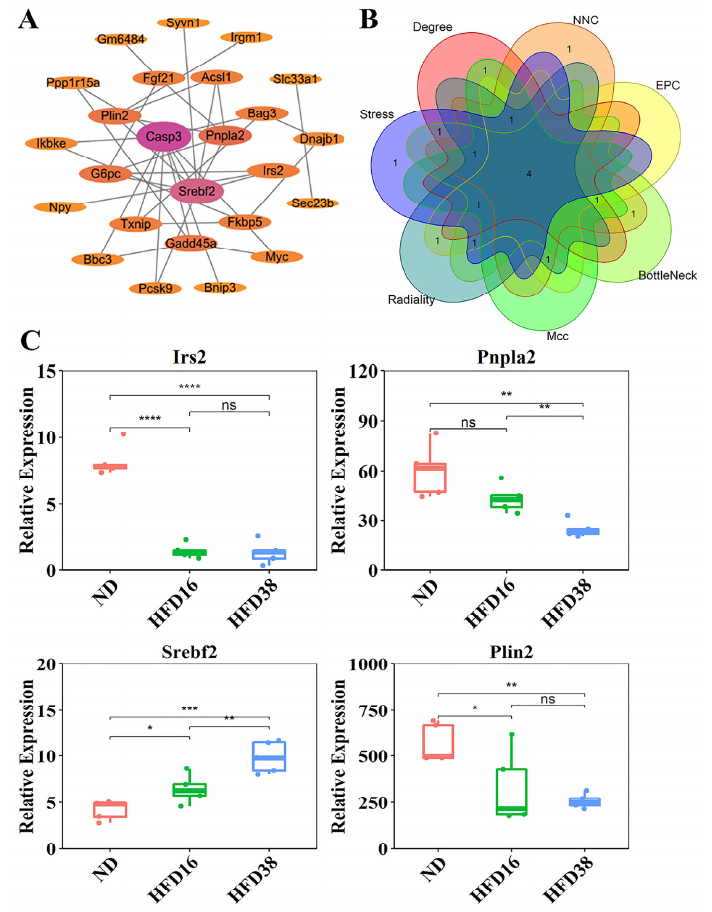
Figure 5. Screening of protein interactions (PPIs) and hub genes. ( A ) PPI network of 31 DEGs. The minimum required interaction score is 0.4, consisting of 25 nodes (genes) and 36 edges (interactions); ( B ) screening four hub genes based on seven algorithms; ( C ) hub gene Irs2, Pnpla2, Srebf2 , and Plin2 expression. The expression of Irs2, Pnpla2 and Plin2 was significantly downregulated in the 38 ‐ week high ‐ fat diet, while the expression of Srebf2 was significantly upregulated in the 38 ‐ week high ‐ fat diet. * p < 0.05; ** p < 0.01; *** p < 0.001; **** p < 0.0001; ns p > 0.05.